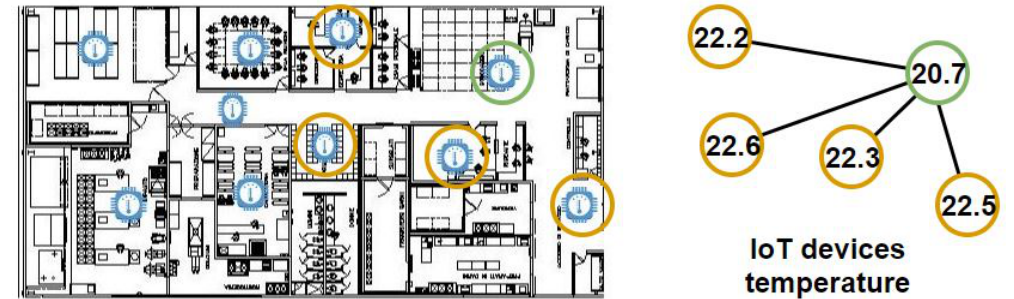
Figure 3. Smart building with an IoT network. The measurements from each device are sent to a consensus algorithm to be processed. There are five IoT temperature measurements, four from accurate IoT devices (orange), and another one from an inaccurate IoT